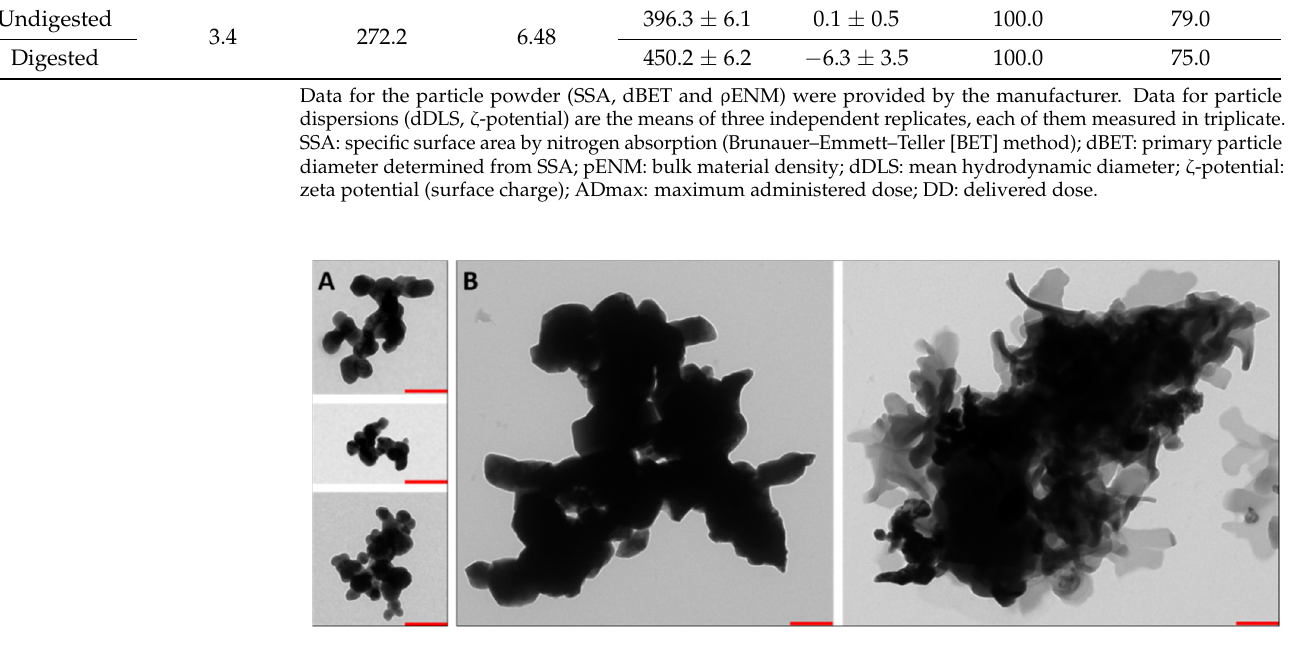
Figure 2. Impact of artificial digestion on the appearance of copper oxide nanoparticles (CuO-NP). Representative transmission electron microscopy images of agglomerates and/or aggregates of ( A ) undigested and ( B ) digested CuO-NP are shown. The red bars represent 250 nm. After digestion, CuO-NP showed a significantly lower ( − 6.3 ± 3.5 mV; p < 0.05) zeta potential compared with that of undigested CuO-NP (0.1 ± 0.5 mV; Table